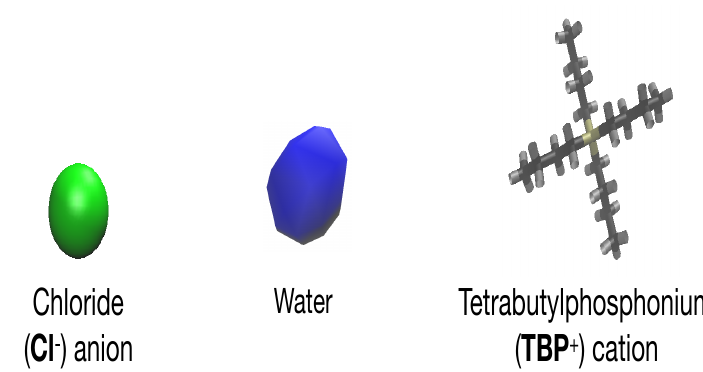
Figure A5. Representation of molecules for the TBPCl–water solution. The blue-colored water is represented using an isosurface drawing method (called quicksurf in VMD [13]), which uses a volumetric Gaussian density map of the water to produce the observable surface. The TBP molecule is represented using dynamic bonds in VMD [13]. TBP is colored tan, black and gray, for the phosphorus, carbon, and hydrogen atoms, respectively. The green chloride is represented using the Van Der Walls (VDW) drawing method in VMD [13].